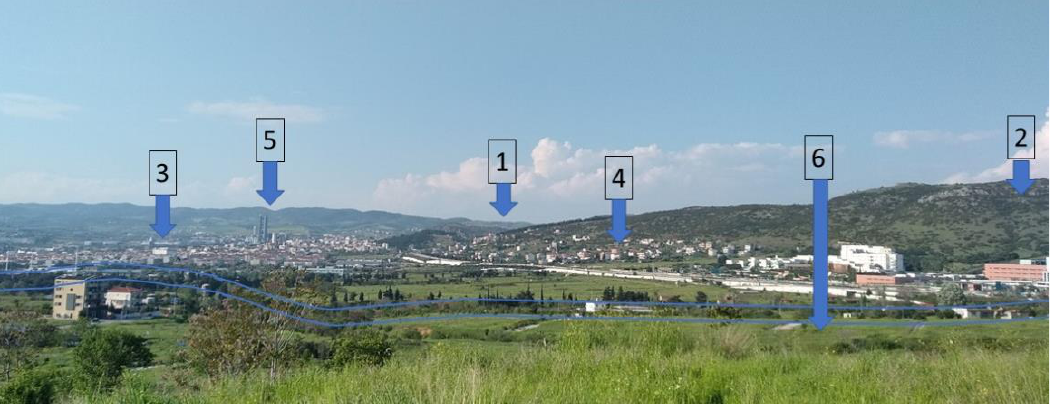
Figure 2 . Part of the Dendropotamos basin. Arrows showing the different land-use classes (see text).